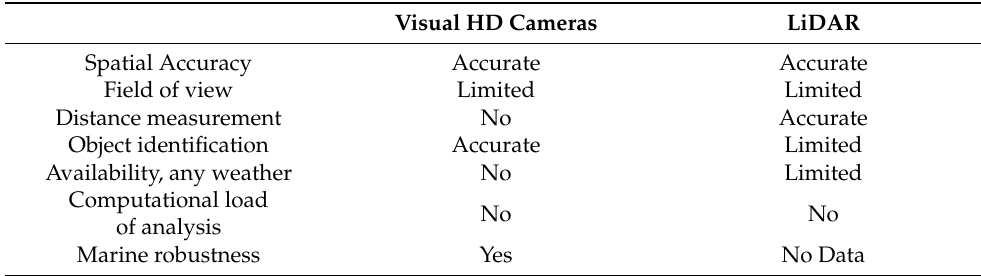
Table 2. Comparison of Camera and LiDAR for Maritime